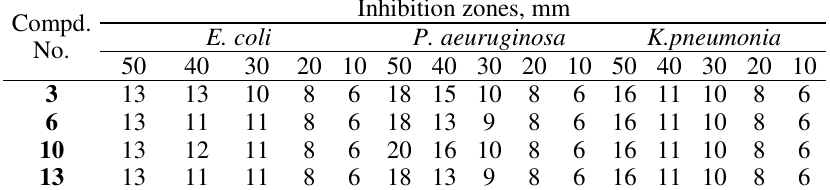
Table 4. MIC of the biological active compounds towards gram negative bacteria Inhibition zones,